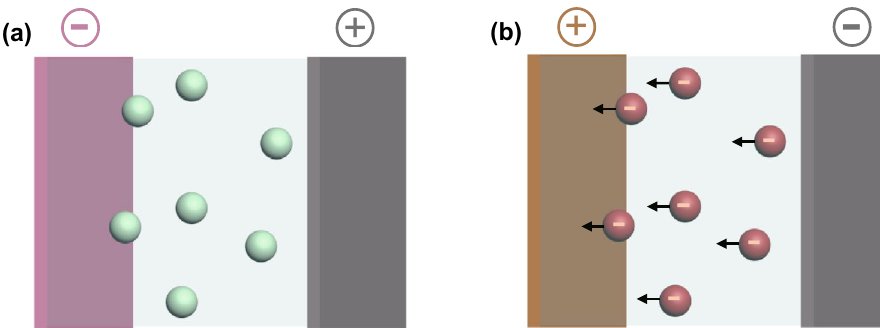
Fig. 6 Schematic illustrations of a cathodic and b anodic electrophoretic deposition. Only ions of interest are shown for